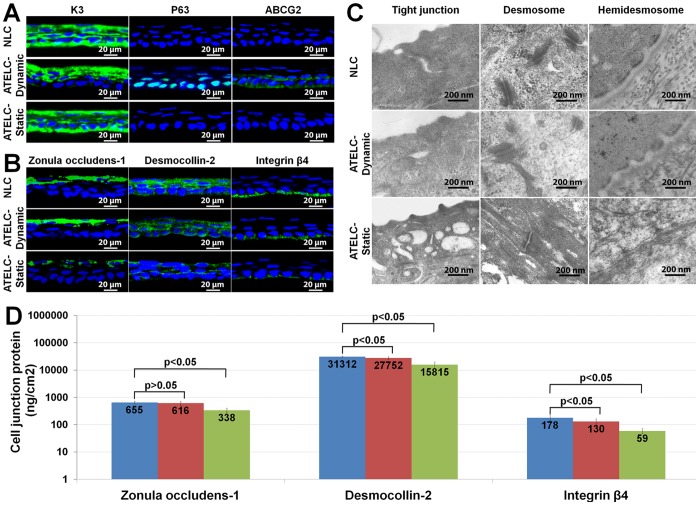
The differentiation phenotype and adhesion property of the epithelium in ATELC-Dynamic.(A) The expressions of K3, P63, ABCG2 proteins. (B) The expressions of zonula occludens-1, desmocollin-2 and integrin β4 proteins. (C) The ultrastructures of tight junction, desmosome junction and hemidesmosome junction. (D) ELISA assay of the zonula occludens-1, desmocollin-2 and integrin β4 proteins.